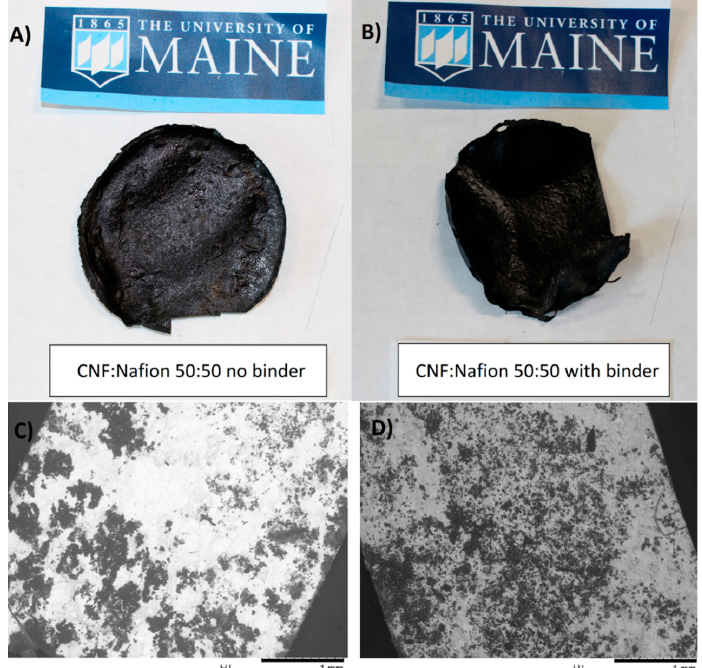
Figure 6. Photographs of selected CNF-Nafion ® ionic polymer-metal composite (IPMC) membranes with/without binder at 50:50 CNF/Nafion ® ratio, as made by electroless chemical plating of platinum ( A and B ), and example SEMs of acceptable ( C ) versus unacceptable ( D ) plated sides of a 50:50 CNF/Nafion ® sample, showing differences in the quality of plating on different sides.